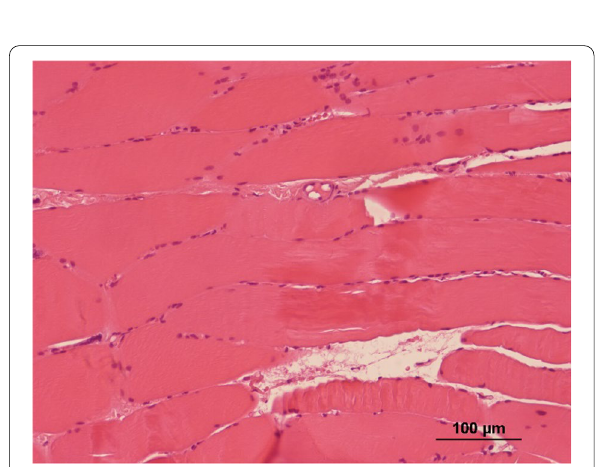
Fig. 4 Optic microscopy of the muscle: discrete abnormalities without specific